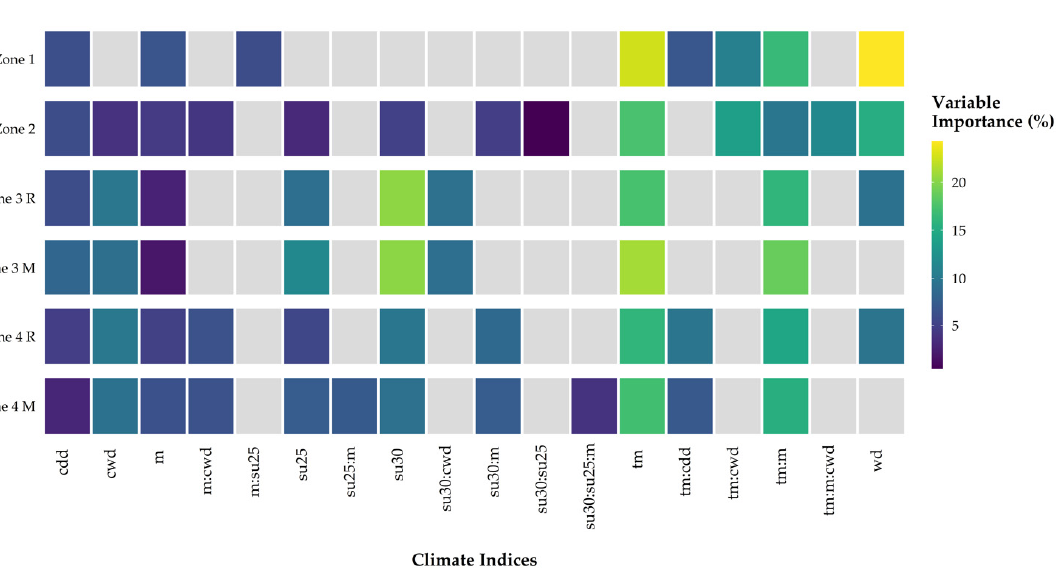
Figure 3. Variable importance MLR model for each zone. All colored boxes represent variables that were used in each individual MLR model, variables that were not used are colored grey. The color gradient shows the variable importance for each zone; consecutive dry days (cdd), consecutive wet days (cwd), month (m), summer days (su25), hot days (su30), air temperature (tm) and days of the week (wd).